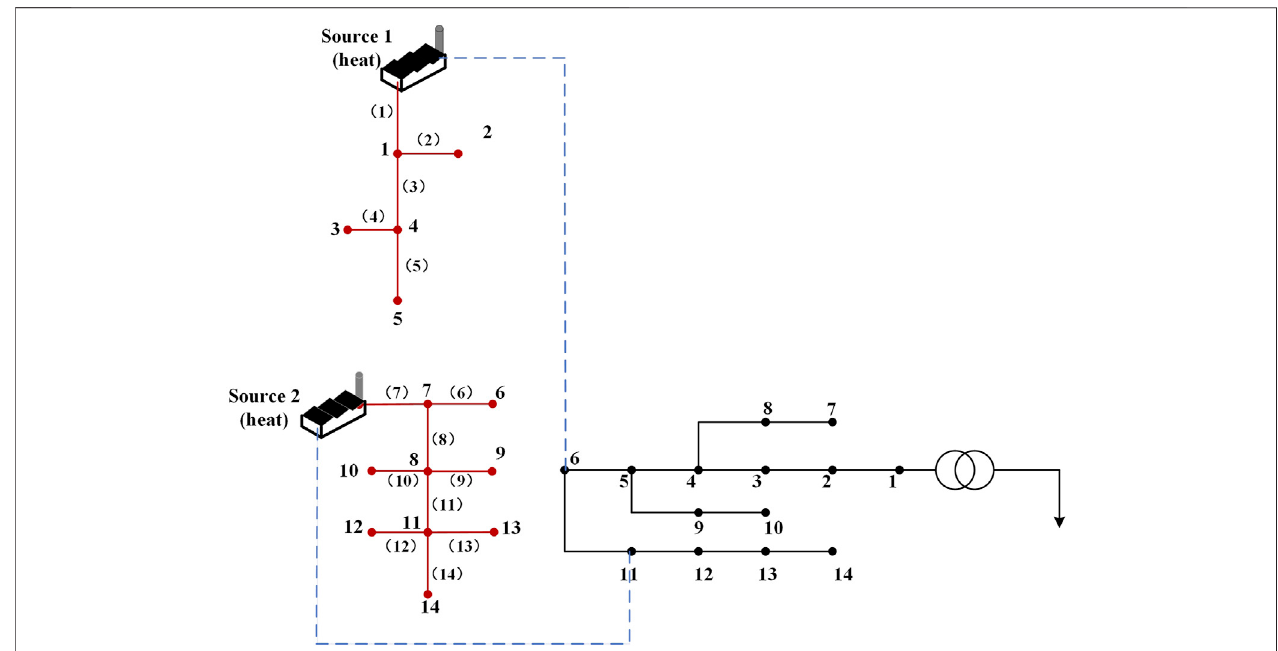
FIGURE 5 | Test model of the electrothermal combined